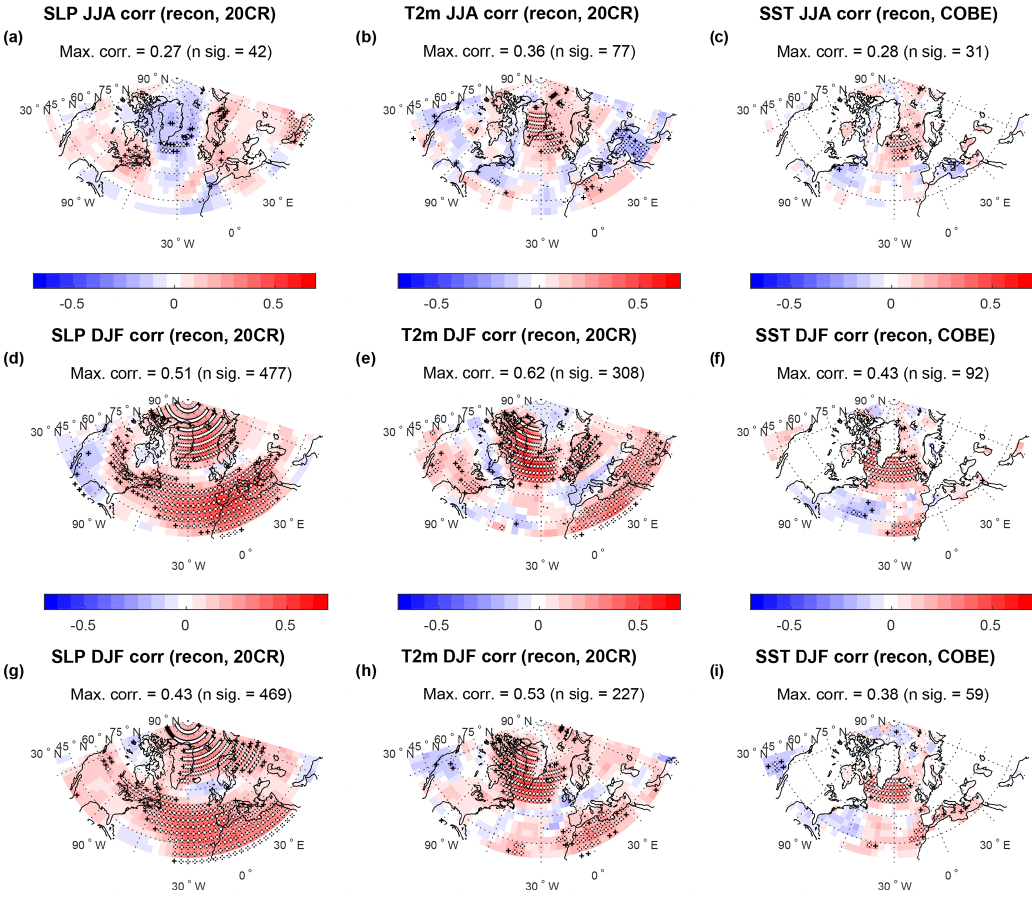
Figure 3. (a–c) Correlation between reconstructed (eight ice cores) and reanalysis SLP, T2m and COBE SST for JJA. The reanalysis data have been interpolated to the model grid (3 . 75 ◦ × 3 . 75 ◦ ). Black markers indicate p < 0 . 05, and white markers indicate p < 0.025. Also indicated is the maximum correlation (Max. corr.) and the number of significantly correlated grid points ( n sig.) ( p < 0 . 05). Panels (d) – (f) are the same as (a) – (c) but for DJF. Panels (g) – (i) are the same as (a) – (c) but for DJF reconstructed from the winter-centered annual mean ice core data. Figure S7 shows corresponding figures for the reconstructions using 19 ice